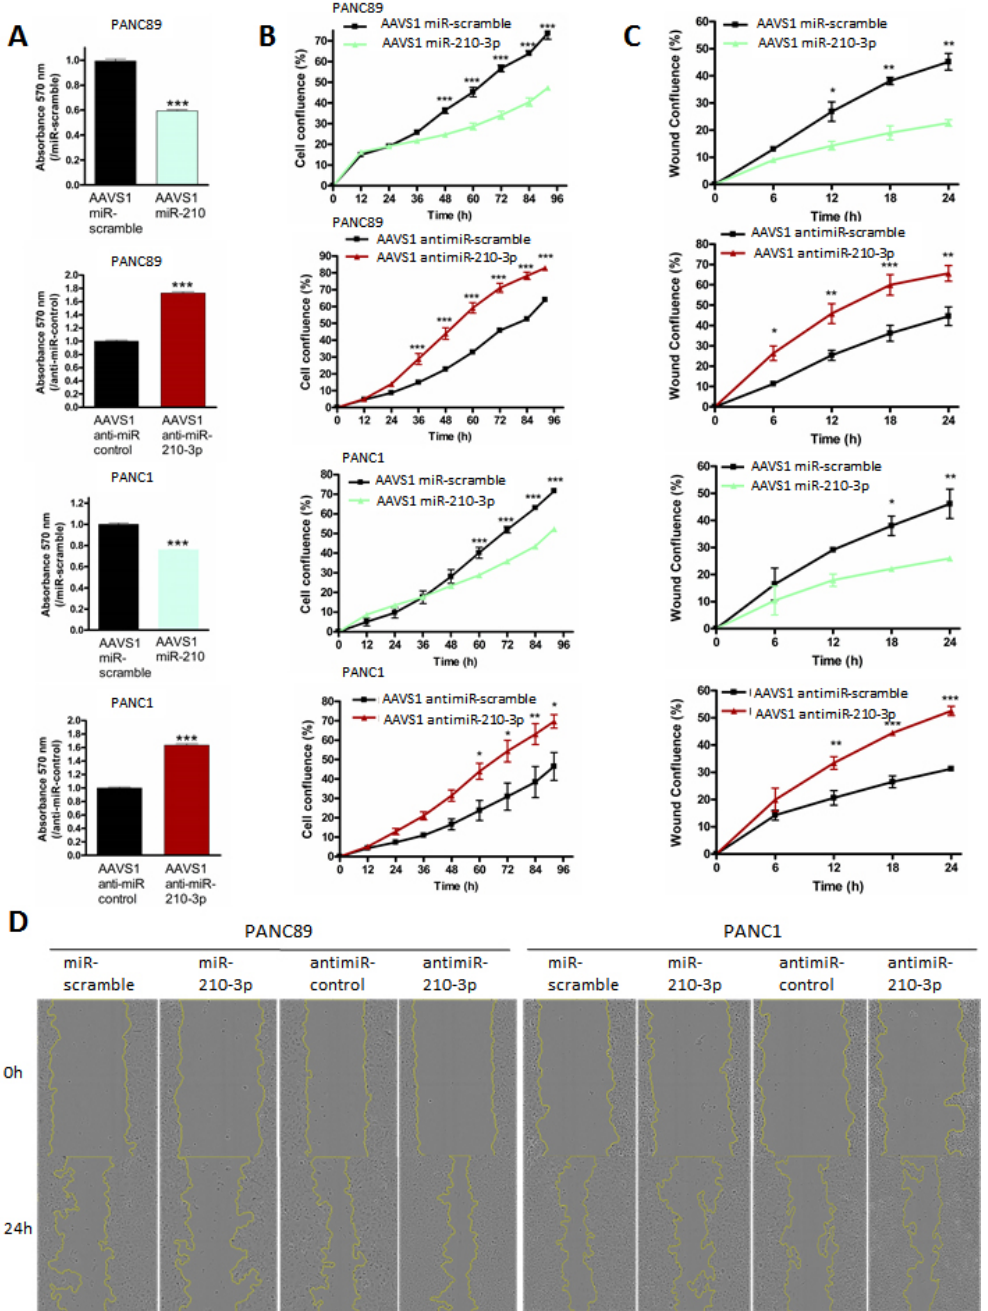
Figure 6. Stable expression of miR-210-3p and anti-miR-210-3p regulate the proliferation and migration of pancreatic cancer cells. PANC89 and PANC1 cells were stably transfected with either miR-210-3p, anti-miR-210-3p or miR-scramble and anti-miR-scramble corresponding controls using CRISPR/Cas9 recombination at the AAVS1 integration site. ( A ) Cell viability was assessed using MTT assays. MiR-scramble or anti-miR-scramble conditions were arbitrarily set to 1. Three independent experiments were performed. ( B ) Cell confluency was evaluated using the Incucyte™ instrument every 12 h during 96 h. Three independent experiments were performed. ( C ) Wound-healing assays were performed after seeding 30,000 cells. Wound area was measured every 6 h during 24 h using the Incucyte™ instrument. Three independent experiments were performed. ( D ) Representative images of wound healing in PANC89 and PANC-1 cells expressing miR-210-3p or anti-miR-210-3p. * p < 0.05, ** p < 0.01 and *** p < 0.001 indicate statistical significance compared to miR-scramble or anti-miR-control.